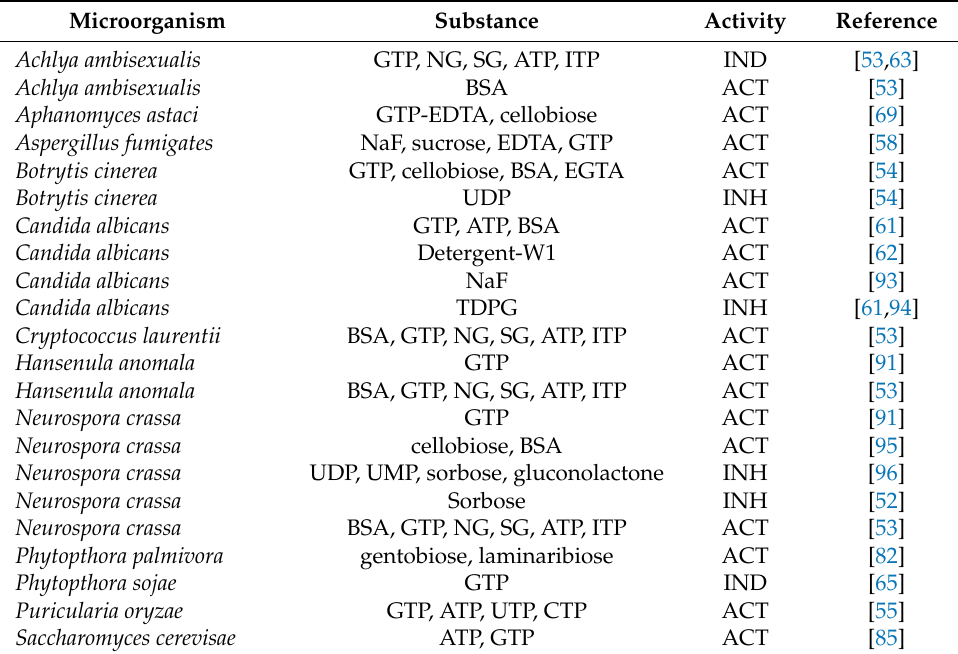
Table 2. Compounds that inhibit, activate or do not affect (independent) the enzymatic activity of GLS from different